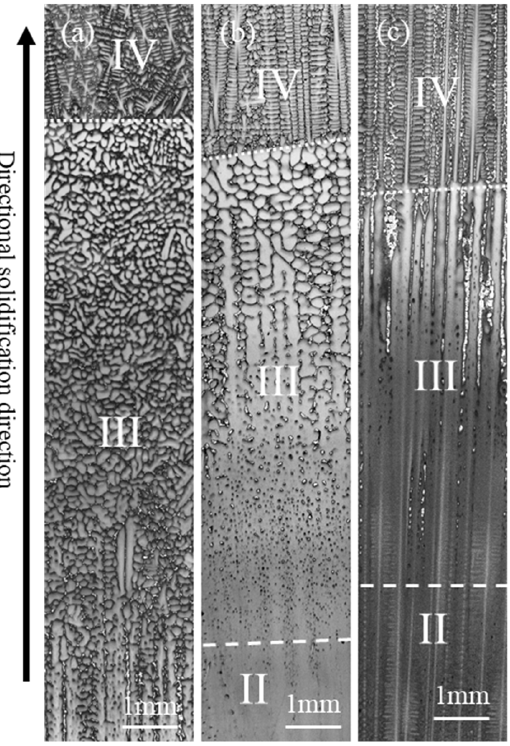
Figure 8. The effect of holding times of ( a ) 3 min, ( b ) 10 min, and ( c ) 25 min on the microstructure in the mushy zone.